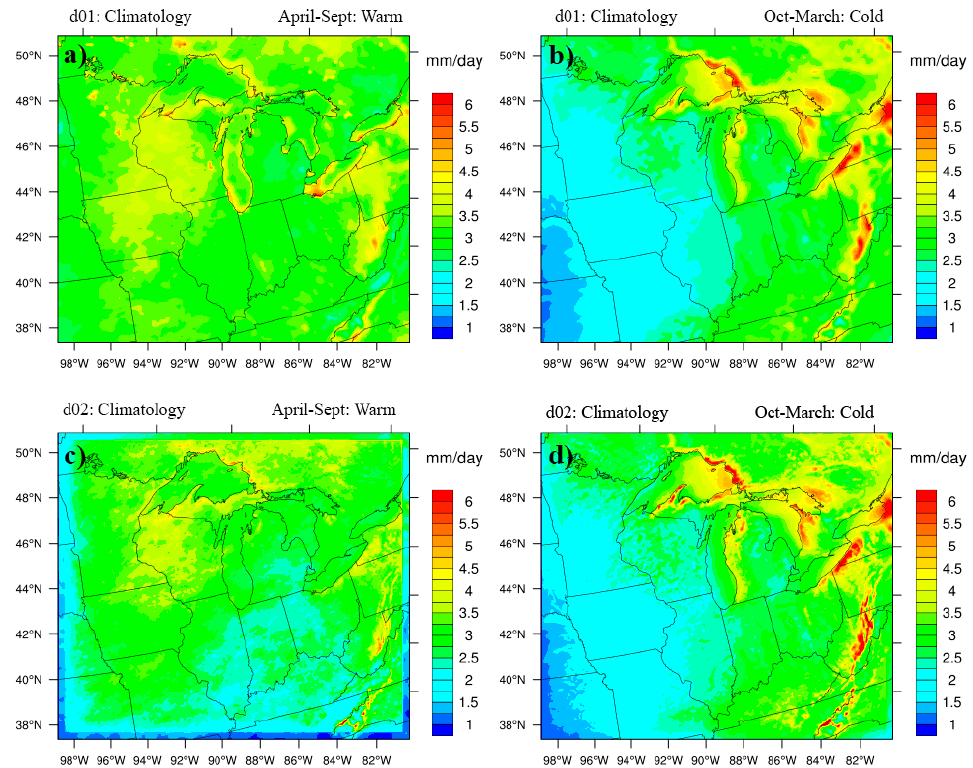
Figure 4. Seasonal climatology of simulated WRF model precipitation for domain at 12-km for ( a ) warm and ( b ) cold season for a period of 10 years from the year 1991 to 2000. Panels ( c ) and ( d ) are the same as ( a ) and ( b ) but for domain at 4-km.